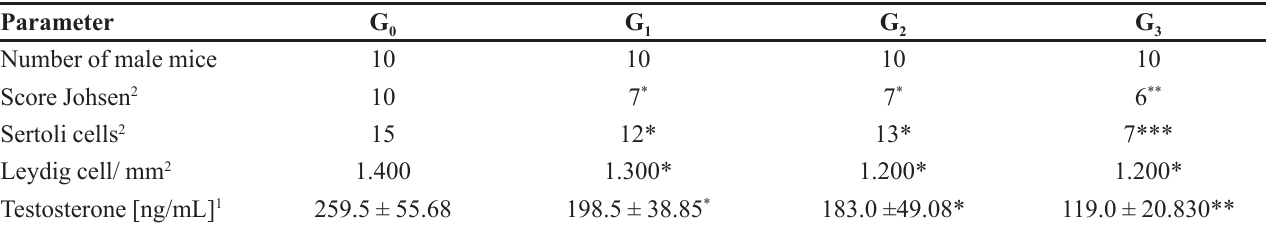
TABLE II - Histological testes and testosterone evaluation Parameter G